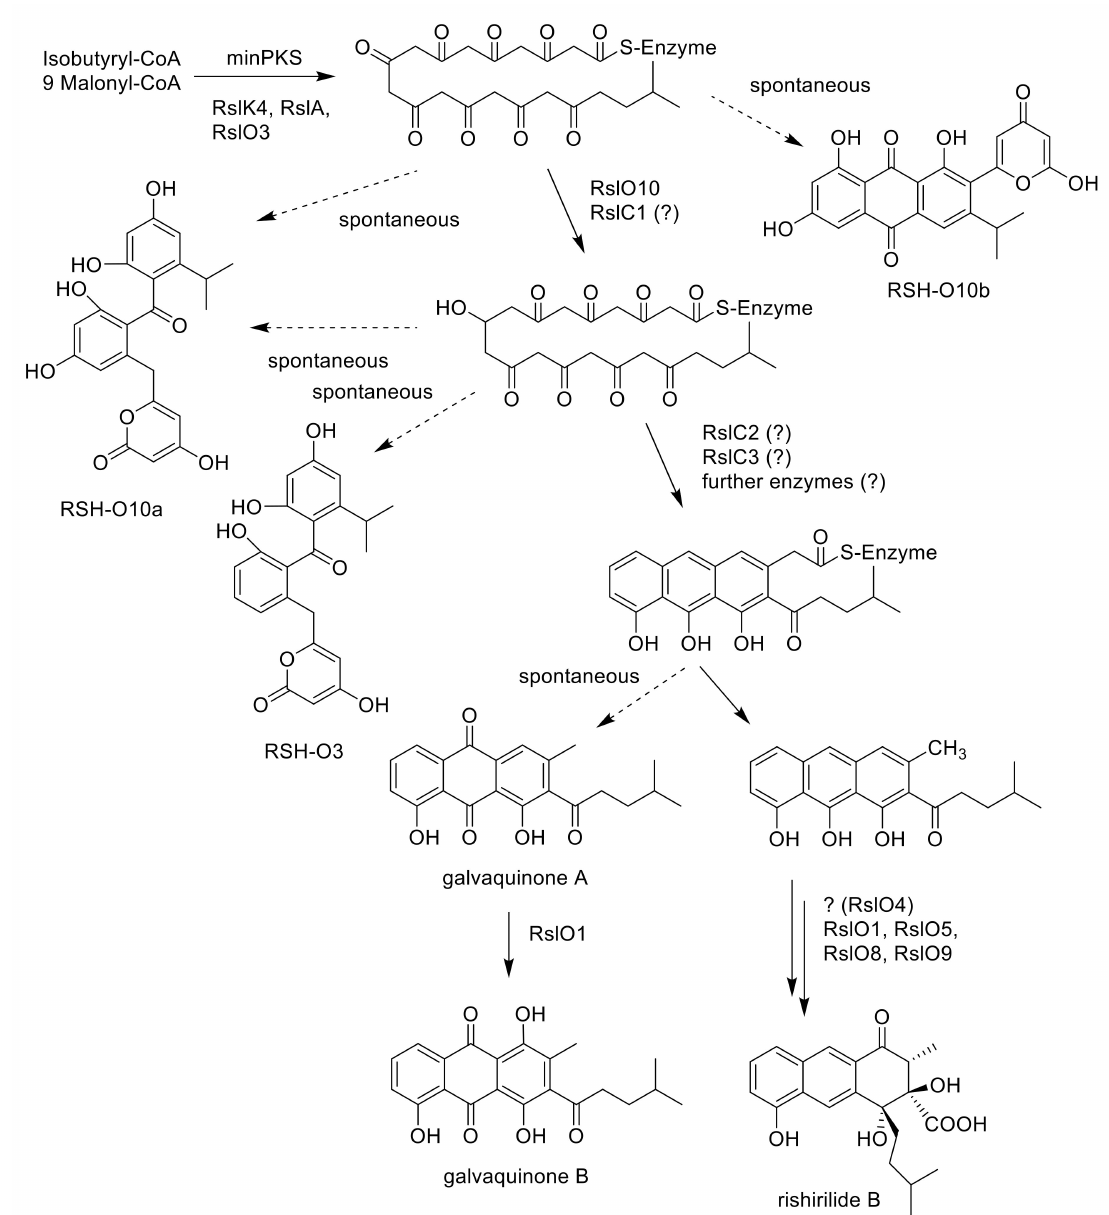
Figure 4. Proposed early steps in the biosynthetic pathway of rishirilide B. RSH-O10a, RSH-O10b. RSH-O3 and galvaquinones A and B are shunt products derived from an unstable